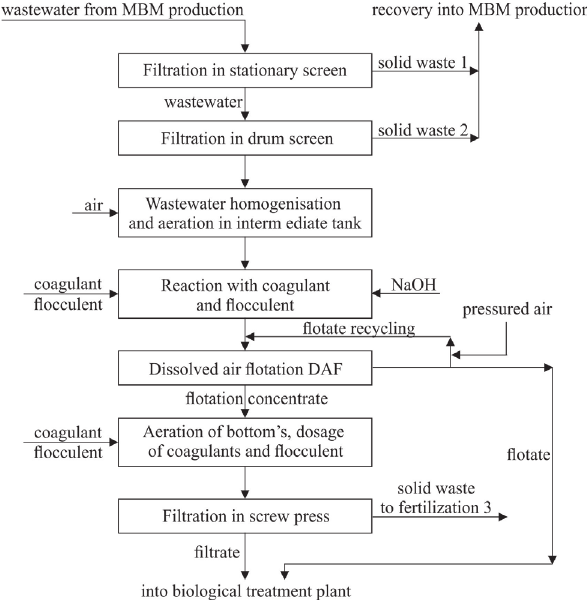
Figure 5: Flow-sheet of industrial pre-treatment unit of wastewater from MBM